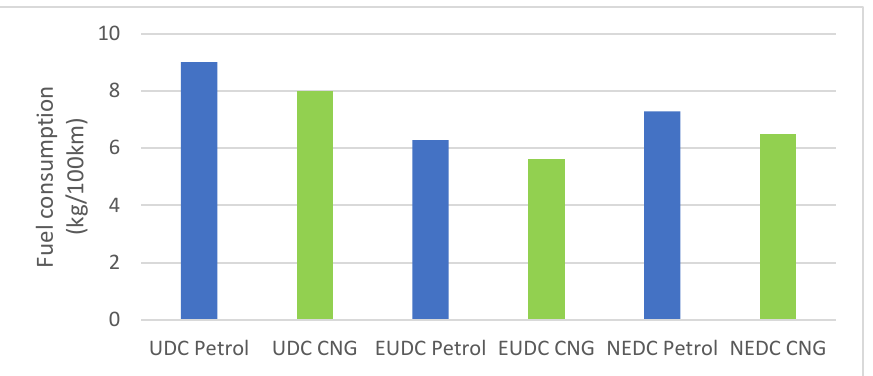
Figure 22. Comparison of fuel consumption between the vehicle fueled with petrol and CNG in the NEDC test.